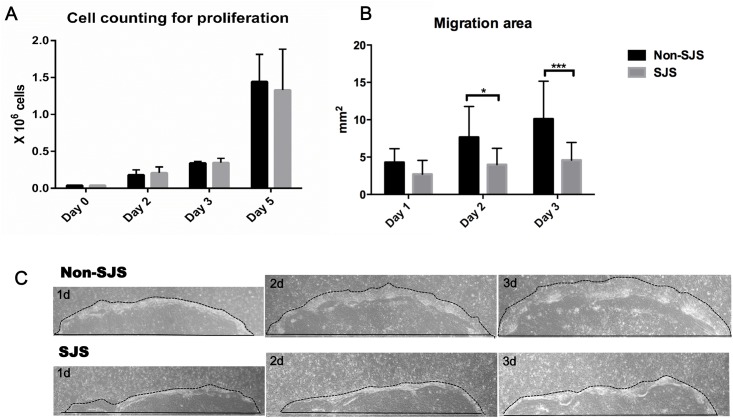
Proliferative and migratory capabilities of cultured oral mucosal epithelial cells from Stevens—Johnson syndrome (SJS) and non-SJS subjects.(A) Cells were counted on days 2, 3, and 5 and did not differ between SJS and non-SJS cells (p>0.05, two-way ANOVA). (B) Migratory potential was significantly delayed in SJS cells when compared to non-SJS cells (*p<0.05, ***p<0.001, RM two-way ANOVA). (C) Image showing cell migration from the edge (black line) (X100). The black line indicates the area that cells migrated each day. SJS indicates mucosal epithelial cells from SJS subjects; non-SJS indicates mucosal epithelial cells from non-SJS subjects.